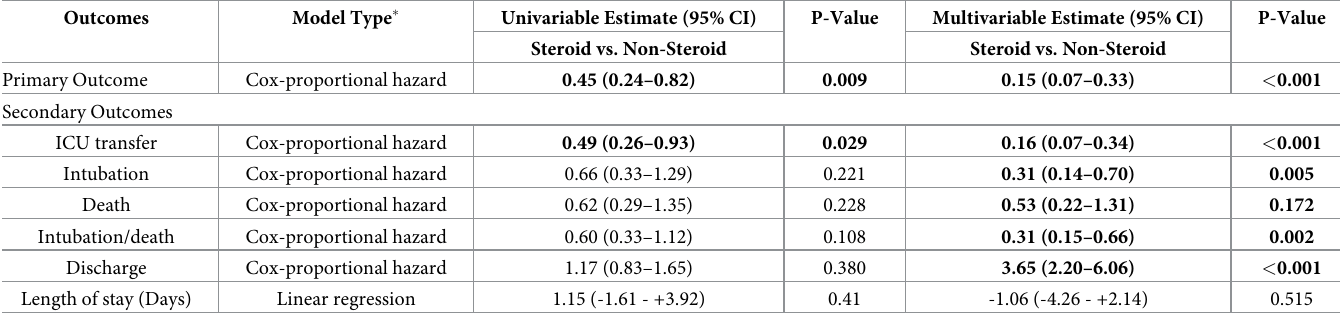
Table 3. Unadjusted and model-adjusted risk of primary and secondary outcomes.